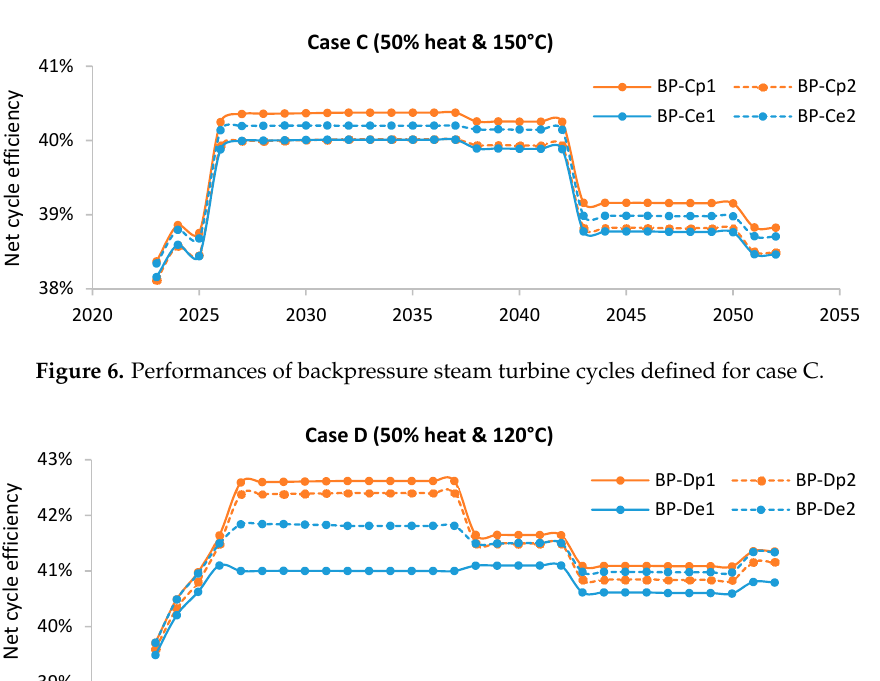
Figure 5. Performances of backpressure steam turbine cycles defined for case B. Energies 2017 , 10 , 744